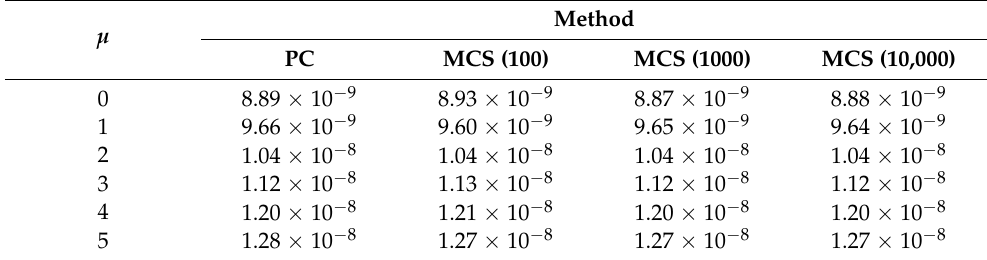
Table 5. The expectation calculated by PC and MCS.